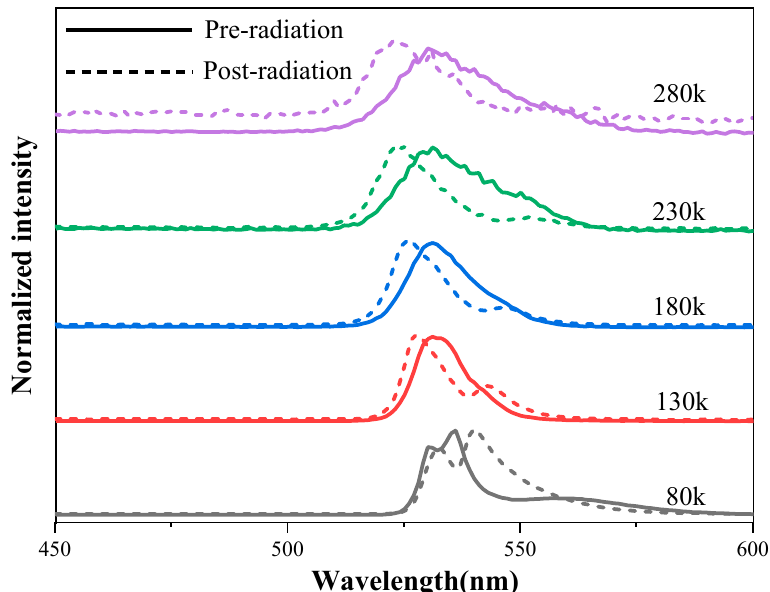
Figure 7. Temperature-dependent PL spectrum excited by a 365 nm laser beam, all normalized to clarify the peak shift.